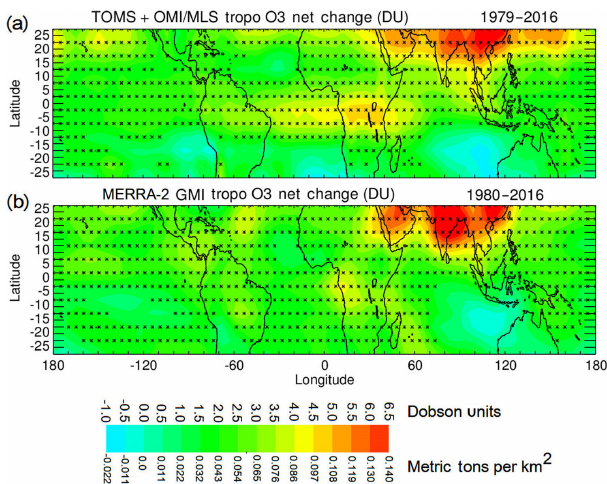
Figure 7. (a) Net changes in TOMS and OMI/MLS TCO calculated for their combined time records (1979–2016). The net changes for TCO are shown in the color bar in both DU and metric tons of ozone per km 2 (1DU ≡ 0 . 0214tkm − 2 for ozone). Asterisks denote grid points where net changes are statistically significant at the 2 σ noise level. (b) Similar to (a) , but for GMI TCO and years 1980–2016. Net change for GMI TCO is determined similar to the satellite mea- surements by adding together the net changes for the two records (i.e., for GMI, the 1980–2005 and 2005–2016